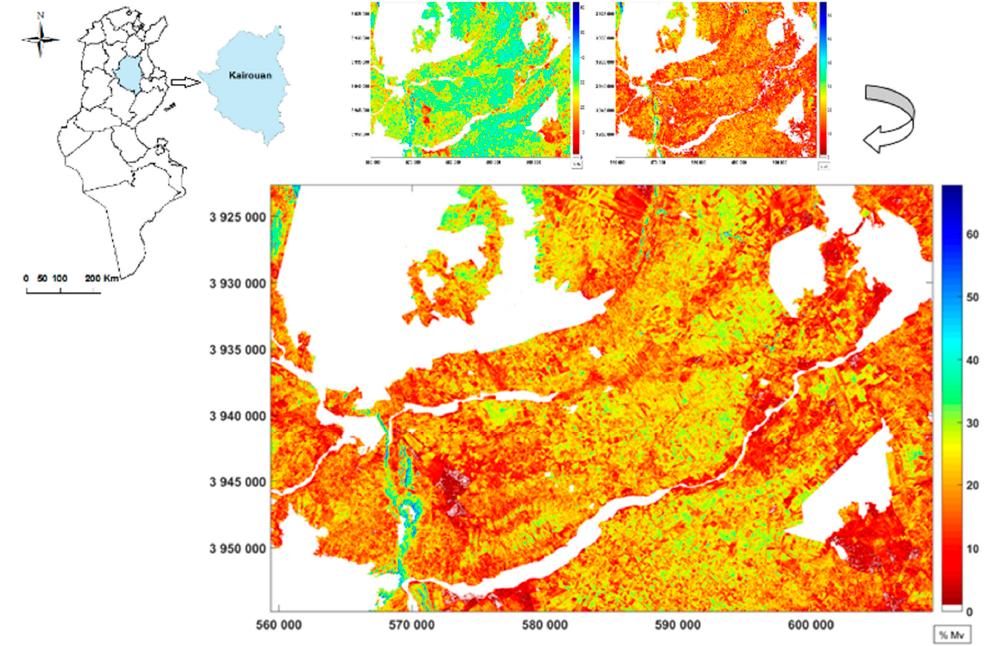
Figure 2. Soil moisture map over the Kairouan Plain, derived from the combined use of Sentinel-1 and Sentinal-2 data, with the upper maps representing 01/12/2017 (in the left) and 20/09/2017 (in the right).